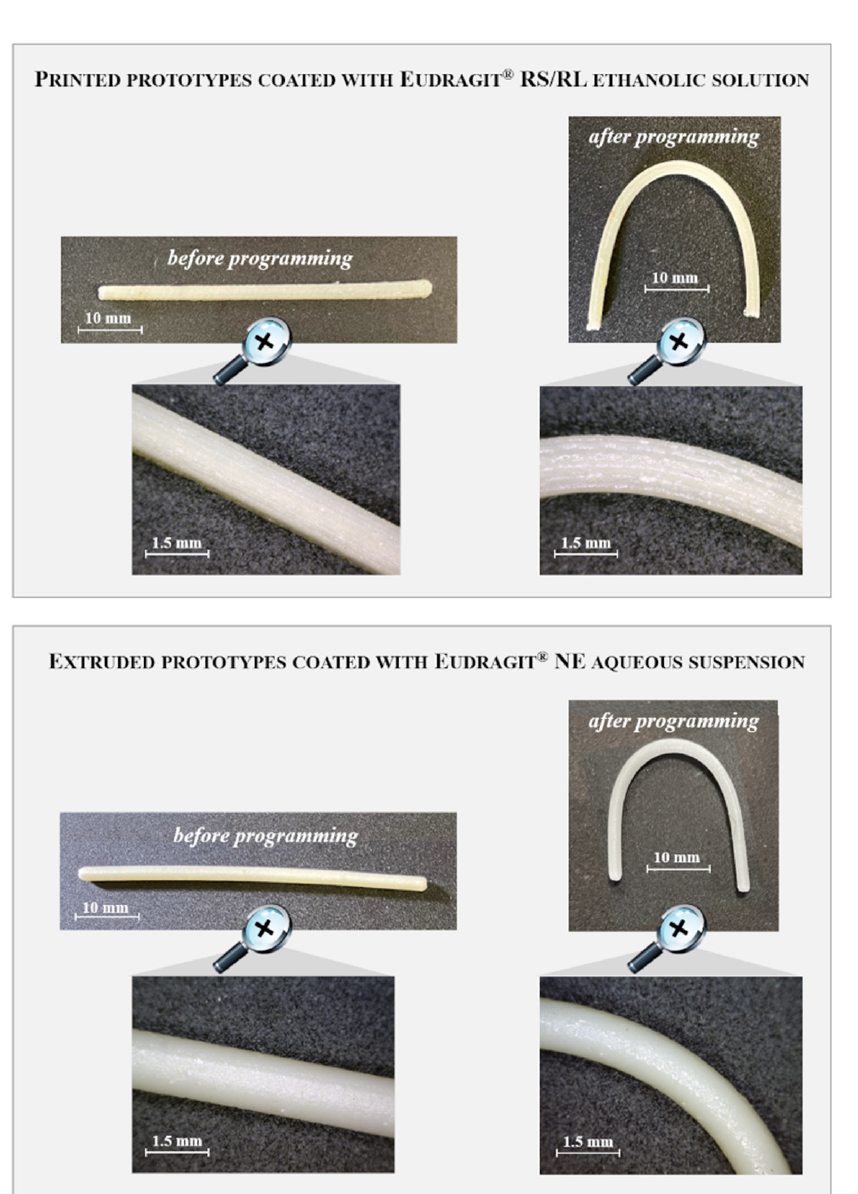
Figure 5. Photographs of extruded and printed samples coated with Eudragit ® RS/RL ethanolic solution and Eudragit ® NE water suspension (4 min), before and after programming of the temporary shape.